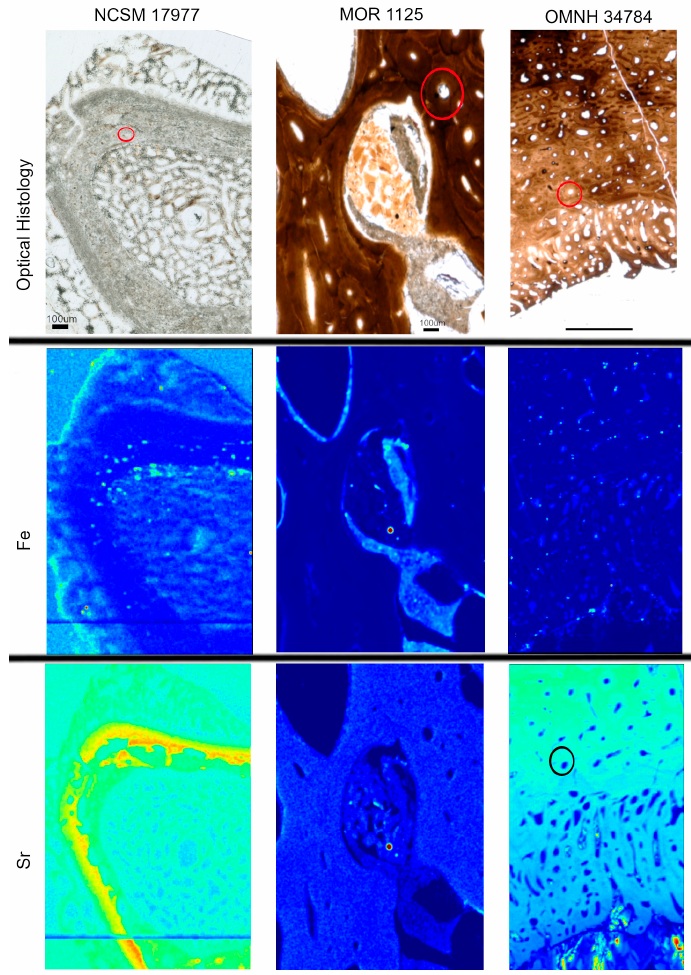
Figure 4. Optical histology and XRF maps taken from beamline 2-3 of Fe and Sr for all specimens. Warmer colors correspond to higher concentrations. Fe is concentrated in spaces between pathologic tissues in NCSM 17977 and within areas of infill between tissues in MOR 1125 and OMNH 34784. Sr is elevated in thicker cortical bone versus the thin trabeculae of the pathologic tissues in NCSM 17977. Sr is relatively uniform in MOR 1125. In OMNH 34784, secondary osteons are highlighted in Sr (example osteon circled).